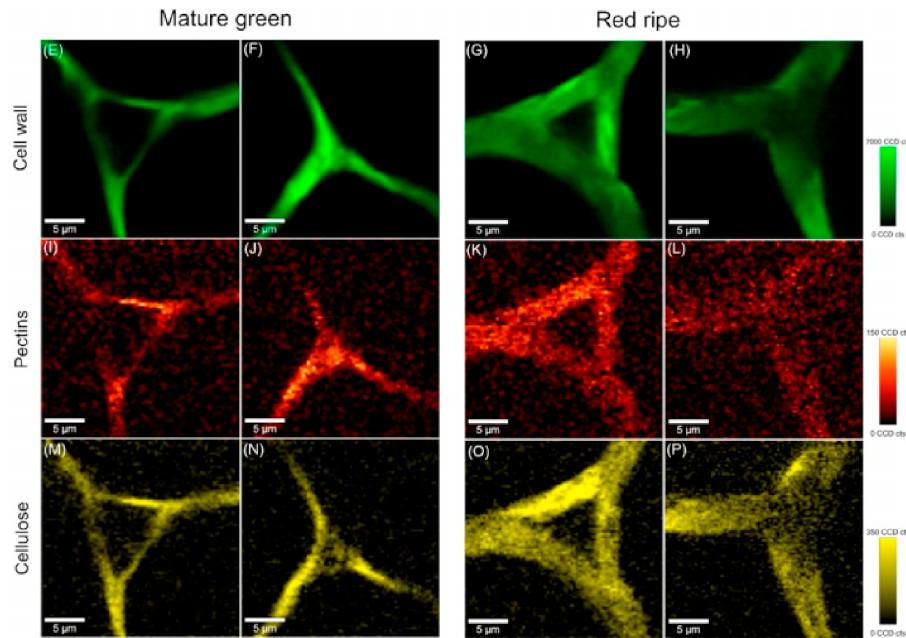
Figure 3. Raman images of cross sections of tomato cell wall from mesocarp at laser with green light ( λ = 532 nm); a power of 25 mW and integration time at 0.1 s was chosen. Raman images of all primary cell wall polysaccharides at 2936 cm − 1 , γ (CH) ( E – H ). Raman images of pectin at 854 cm − 1 , the (COC) skeletal ( I – L ). Raman images of cellulose at 1096 cm − 1 and 1115 cm − 1 (glycosidic bond) ( M – P ). Copyright Plant Physiology and Biochemistry